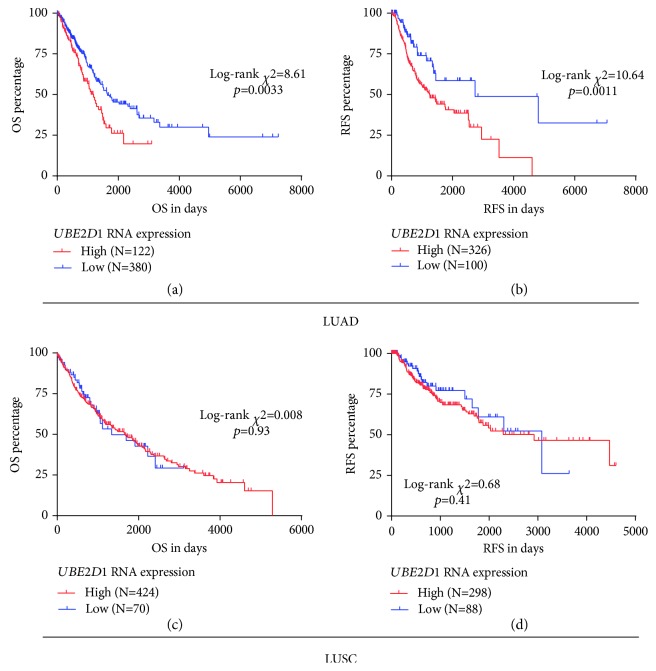
Kaplan-Meier curves of OS and RFS in LUAD and LUSC (a–d). Kaplan-Meier curves of OS (a, c) and RFS (b, d) in LUAD (a–b) and LUSC (c–d) patients. The patients were grouped according to the Youden Index identified in ROC analysis for death and recurrence detection.